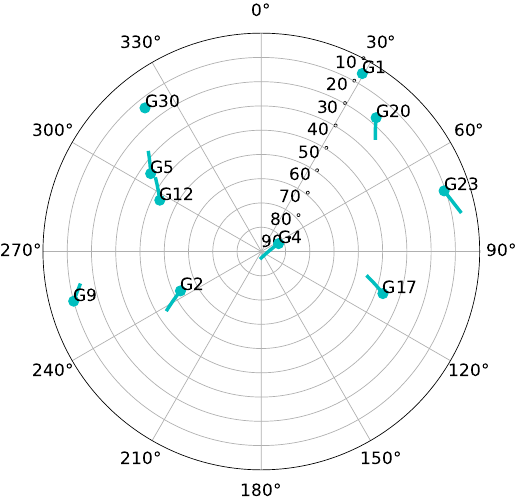
Figure 16. Sky-plot of simulated scenario.